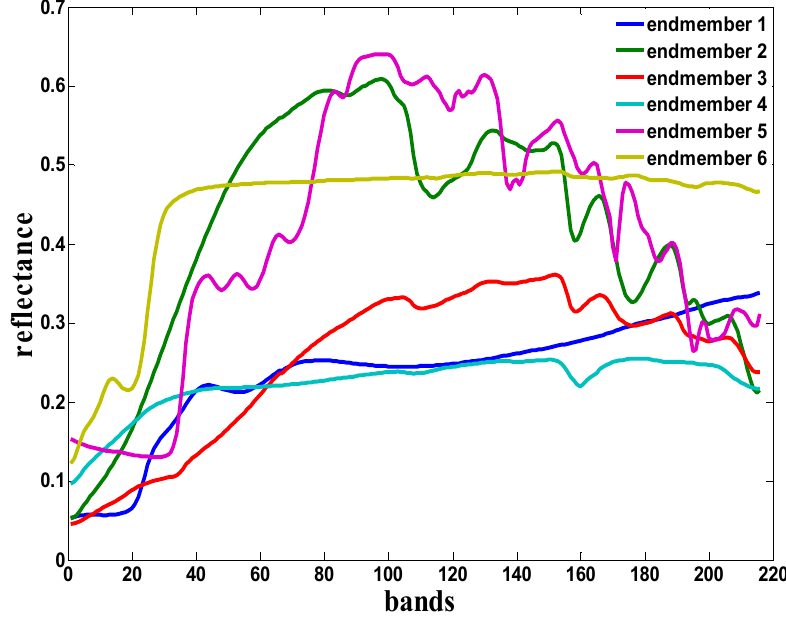
Figure 2. The six selected spectral signatures.